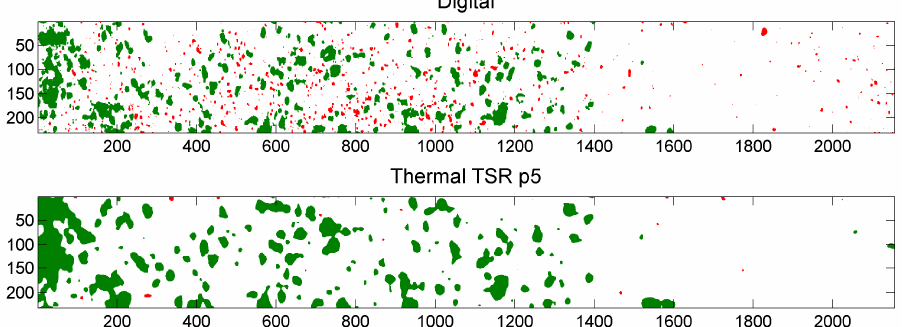
Figure 7. Binarized digital image ( top ); and binarized thermal output image “thermal signal reconstruction (TSR) p 5 ” ( bottom ). Coordinates are shown in pixels. Particles that occur in both images are shown in green. Particles that occur only in the digital image or only in the thermal output image are shown in red in respectively the top image and the bottom image.